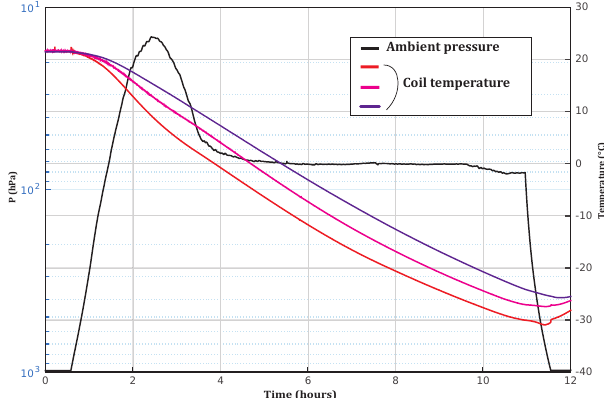
Figure 7. Recorded temperature from the three probes on the AirCore-HR and ambient pressure during the EdS-Stratéole flight on 29 August 2014. The three temperature probes (red, pink and purple lines) are presented in degrees Celsius as a function of time; the temperature axis is located on the right side. Ambient pressure (black line) is presented inhPa as a function of UTC time, with the vertical scale on the left